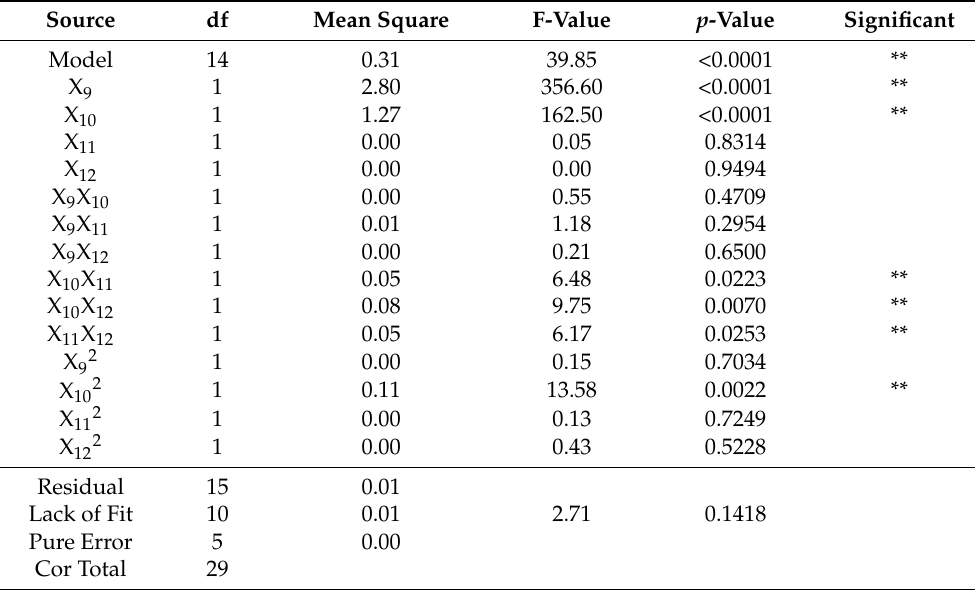
Table 10. Variance analysis of the soil block shear test regression